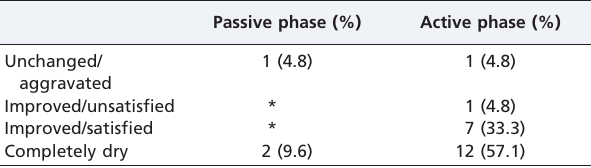
Table 4 - Clinical questionnaire at the beginning and end of the passive and active